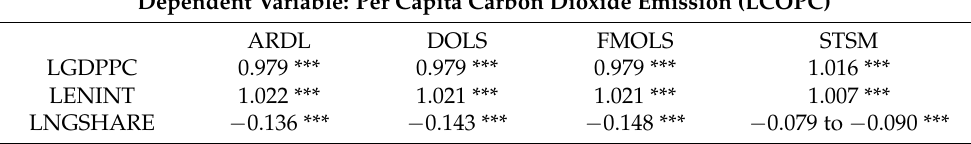
Table 4. Long-run estimation